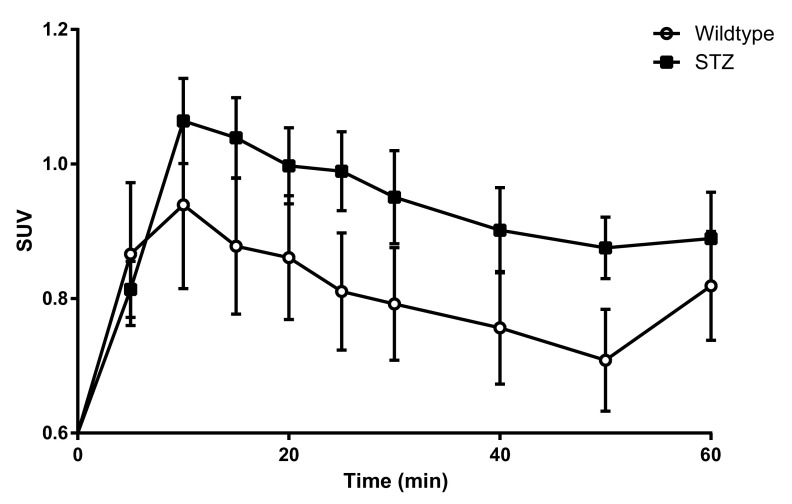
Time-activity curves for
18F-L-FEHTP uptake in the pancreas of wt and STZ-treated mice.TACs are expressed as SUVs from regions corresponding to regions of interest from six image slices corresponding to the pancreas. Values are means ± SEM (n=4). There were no significant differences at any of the time points.